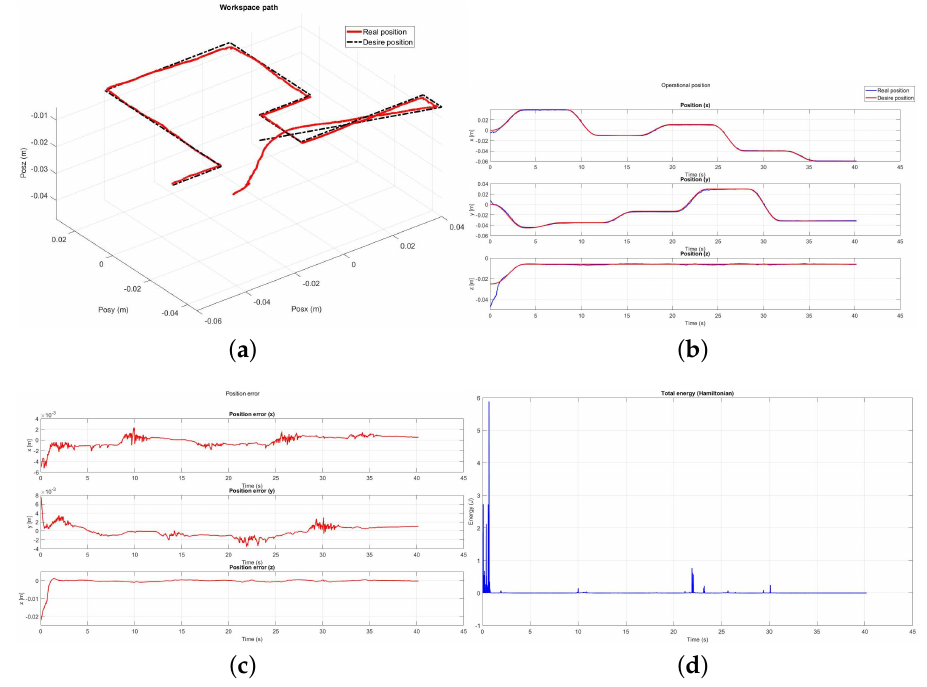
Figure 23. Experimental results with user in the loop: ( a ) Workspace path, ( b ) Operational position, ( c ) Position error, ( d ) Total energy in the task.